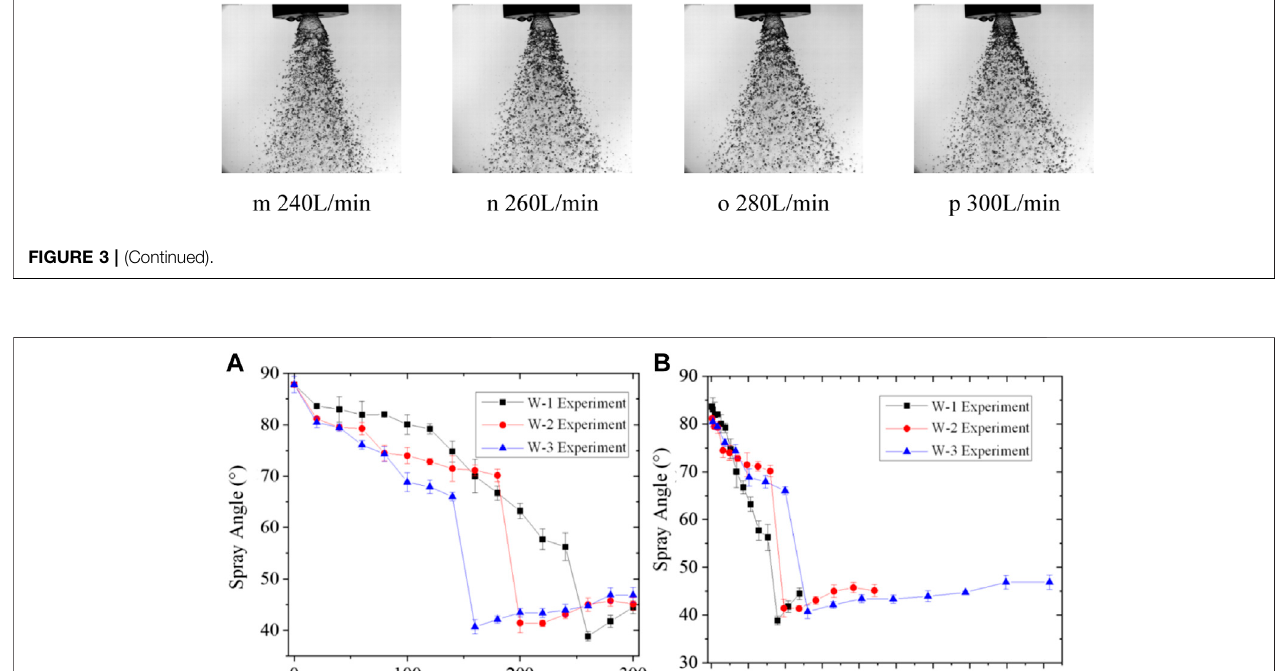
Frontiers in Energy Research |